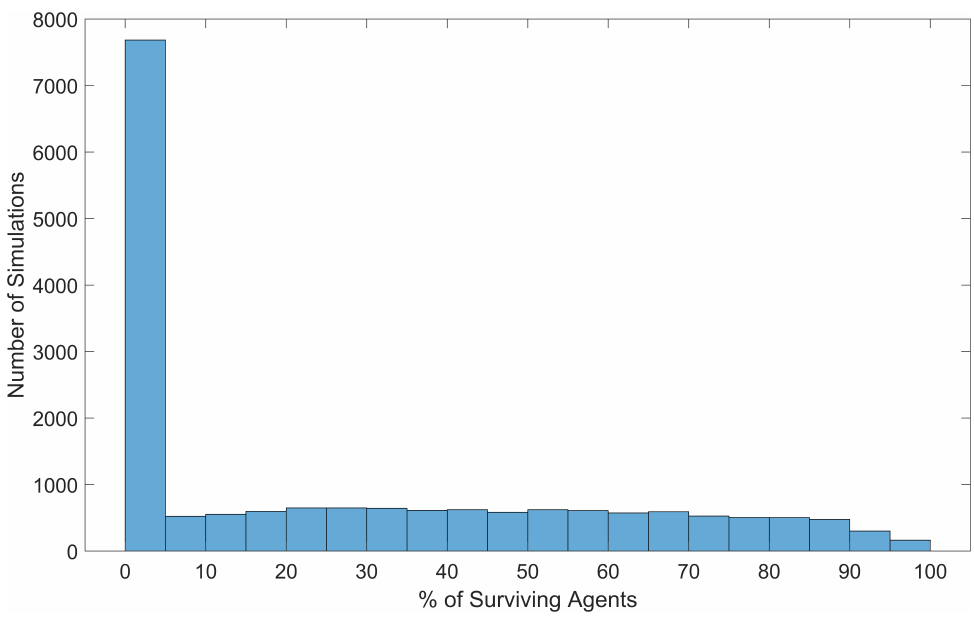
Figure 11. Distribution of swarm survival at the end of each simulation, across all 18,000